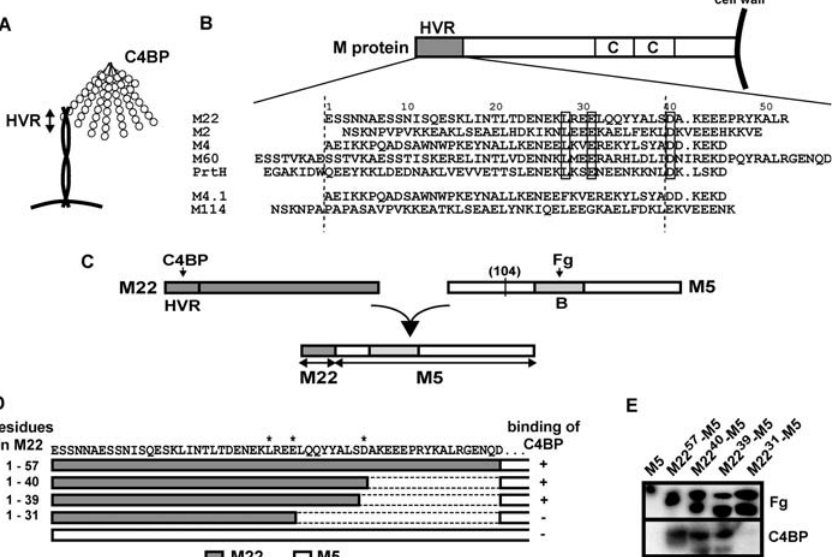
Figure 1. The Binding Site for Human C4BP in the Hypervariable Region (HVR) of M Protein (A) Schematic representation of C4BP bound to the HVR of an M protein, a dimeric coiled-coil. The most common form of C4BP has seven identical a - chains and one short b -chain. Both chains are composed of CCP modules, as indicated. The binding site for M protein in C4BP is located in the CCP1–2 region of the a -chain [17,24,47]. (B) Multiple sequence alignment of HVRs that bind C4BP. The five upper sequences are from [25]. Three residues that are identical in these five sequences are boxed. PrtH is a second M protein expressed by certain M1 strains [35]. The lower part of the alignment shows the HVRs of M4.1 and M114, characterized in this paper. The vertical hatched lines, corresponding to residues 1–39 in M22, indicate the region used to generate the logo in Figure 5A. (C) Construction of fusion proteins derived from the M22 and M5 proteins. An N-terminal region derived from M22 was fused to the C-terminal part of M5 (residues 104–450 of M5). The fusion proteins contain the Fg-binding B-repeat region of M5. (D) Schematic representation of the N-terminal region of different fusion proteins. The sequence of the N-terminal region of M22 is given at the top. Asterisks indicate the position of residues L28, E31, and D40 in M22 (corresponding to the three boxed residues in [B]). The ability of the fusion proteins to bind C4BP, indicated to the right, is based on the results shown in (E). (E) Ability of fusion proteins to bind C4BP. The fusion proteins (D) are referred to as M22 57 –M5, etc. Whole-cell lysates of E. coli strains, expressing the indicated proteins from genes carried on pBR322, were analyzed by Western blot using Fg or C4BP as the probe. The strain expressing M5 was used as a negative control. The control blot with Fg showed that the proteins were expressed in E. coli. The presence of double bands probably reflects incomplete processing of signal peptides in E. coli and/or intracellular degradation of M protein in this heterologous host. DOI: 10.1371/journal.ppat.0020047.g001 PLoS Pathogens |